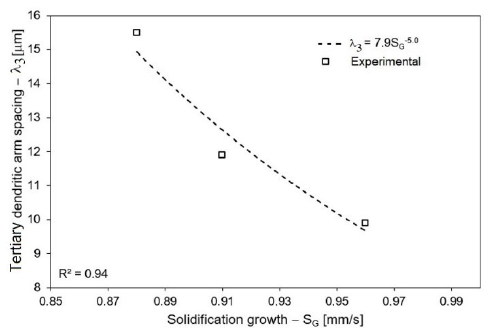
) versus solidification 3